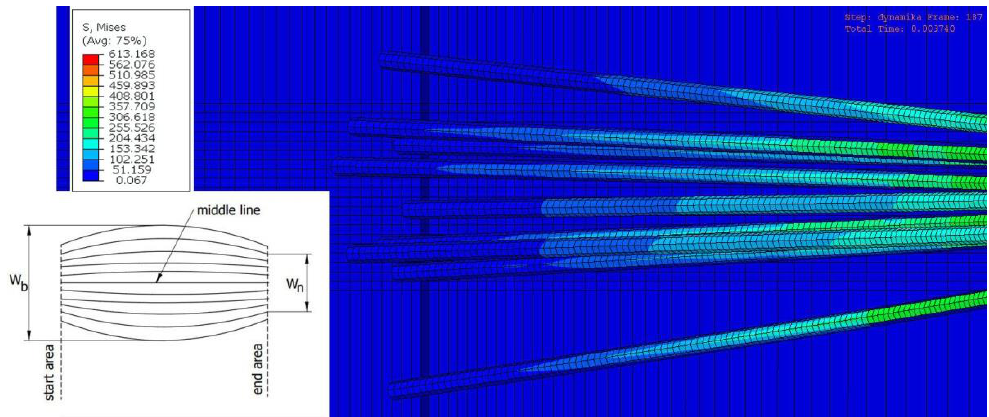
Figure 9. Top view simulation of the fibers passing through the surface defect.